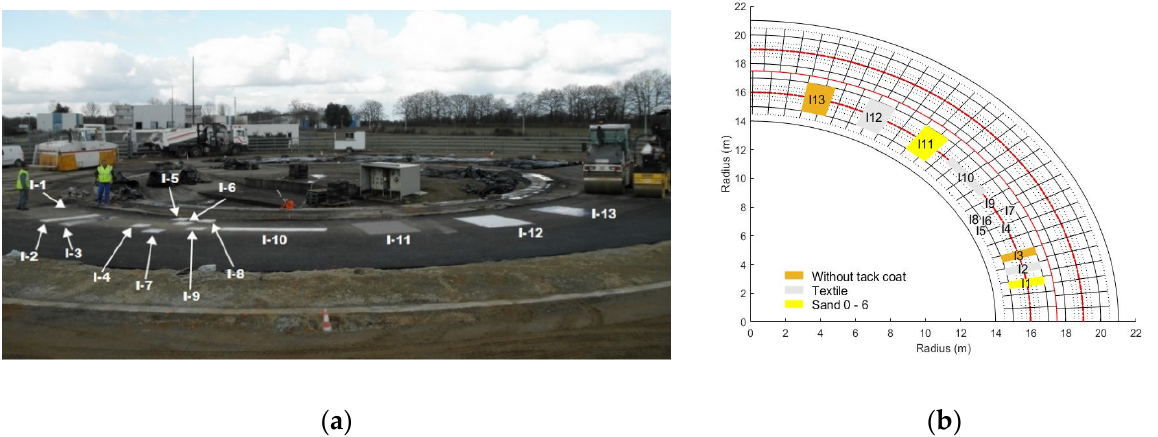
( b ) Figure 3. Impulse radar systems: ( a ) SIR4000 model with a 1.5 GHz antenna, ( b ) 2.6 GHz StructureScan. In the second group, stepped-frequency systems were used—an experimental one developed at university Gustave Eiffel working with an equivalent 5 GHz central fre- quency, and a second one, which is a commercial array system, working with an equiva- lent 1.5 GHz central frequency (Figure 4). In this paper, the “central frequency” of the SFR